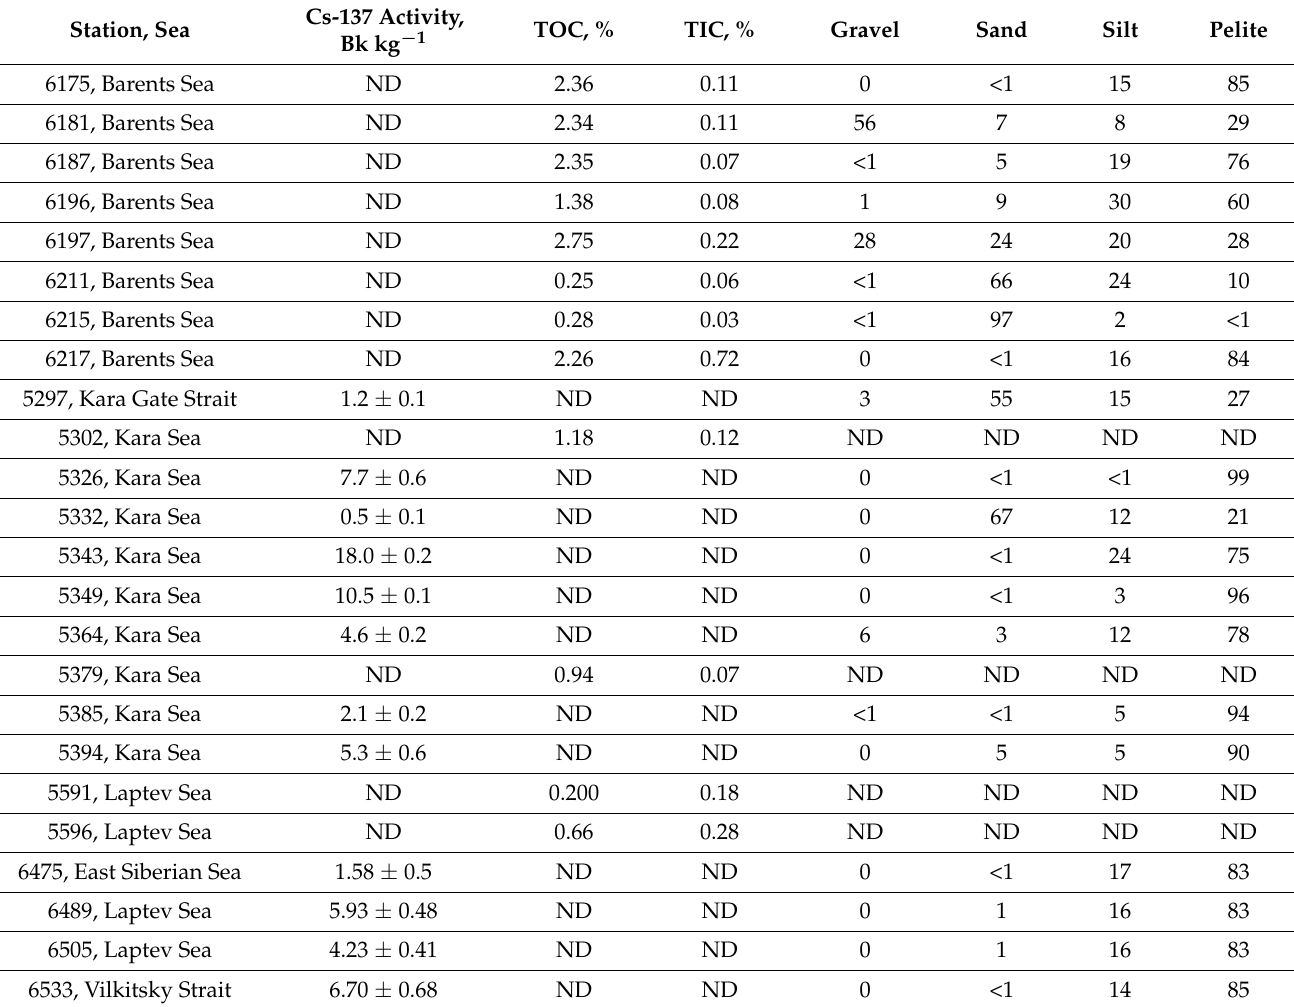
Table 3. The Cs-137 activity and grain-size composition (%) of bottom sediments. ND—no